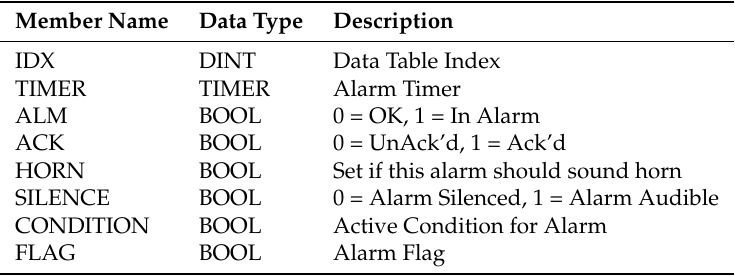
Table 2. User-defined data type for alarms, original